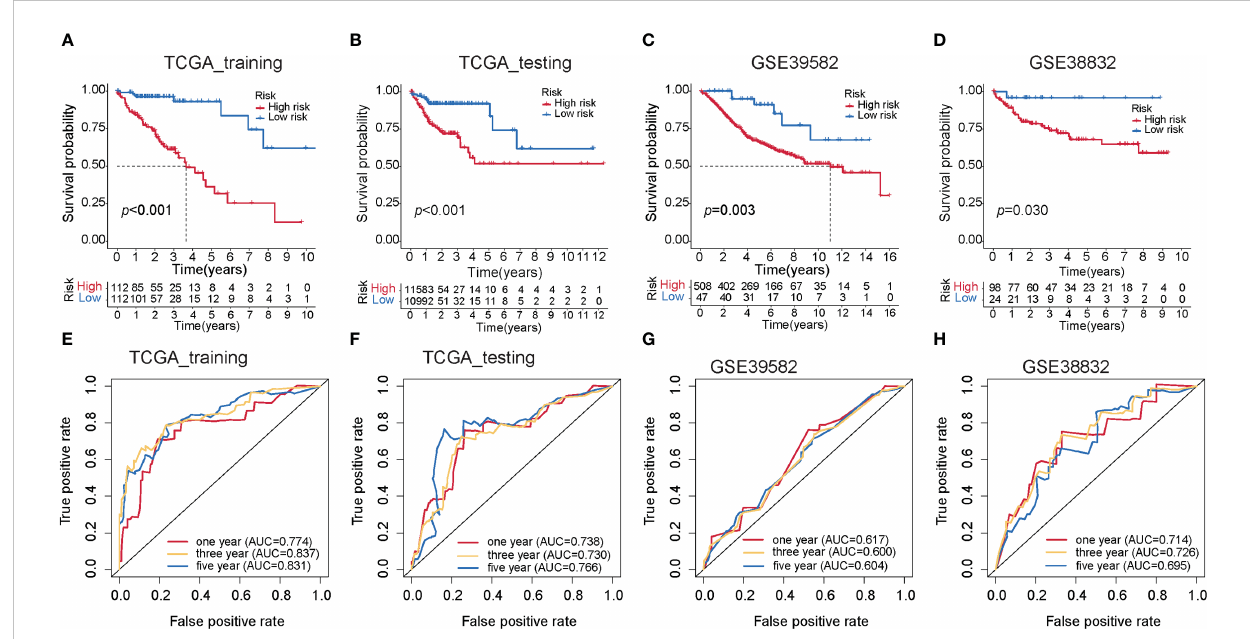
FIGURE 5 Construction of the MKPC score. Survival curves (log-rank test) of MKPC score in (A) TCGA training set, (B) TCGA test set, (C) GSE39582, (D) GSE38832, (E – H) ROC curves of MKPC score in (E) TCGA training set, (F) TCGA test set, (G) GSE39582, and (H)